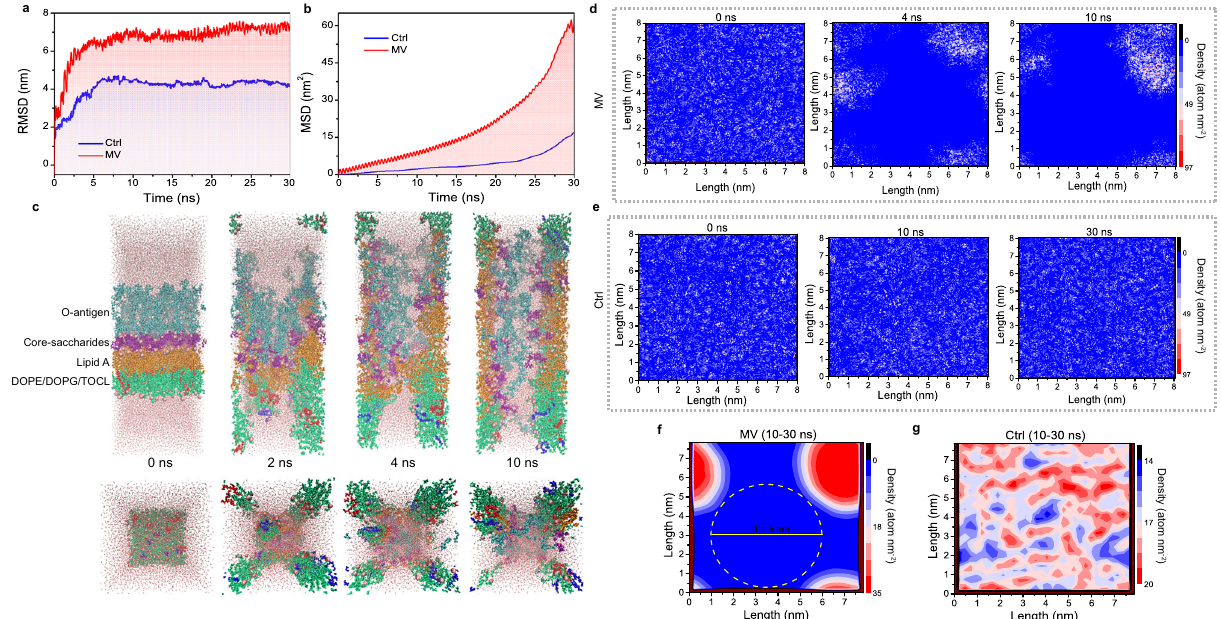
Fig. 2 Molecular dynamics simulation of MV-induced nanopores in the OM of E. coli . a, b The evolution of RMSD ( a ) and MSD ( b ) of the OM in Ctrl and MV group. c The conformational change of the OM after MV application at 0 ns, 2 ns, 4 ns, and 10 ns. Front view (above); Bottom view (below). d Two- dimensional graph of density evolution of OM after MV application at 0 ns, 4 ns, and 10 ns. e Two-dimensional graph of density change of OM in the group of Ctrl at 0 ns, 10 ns, and 30 ns. f, g Two-dimensional graph of the average density of the OM in the equilibrium phase (10 – 30 ns) in MV ( f ) and Ctrl ( g ) group. d, diameter. Source data are provided as a Source Data fi